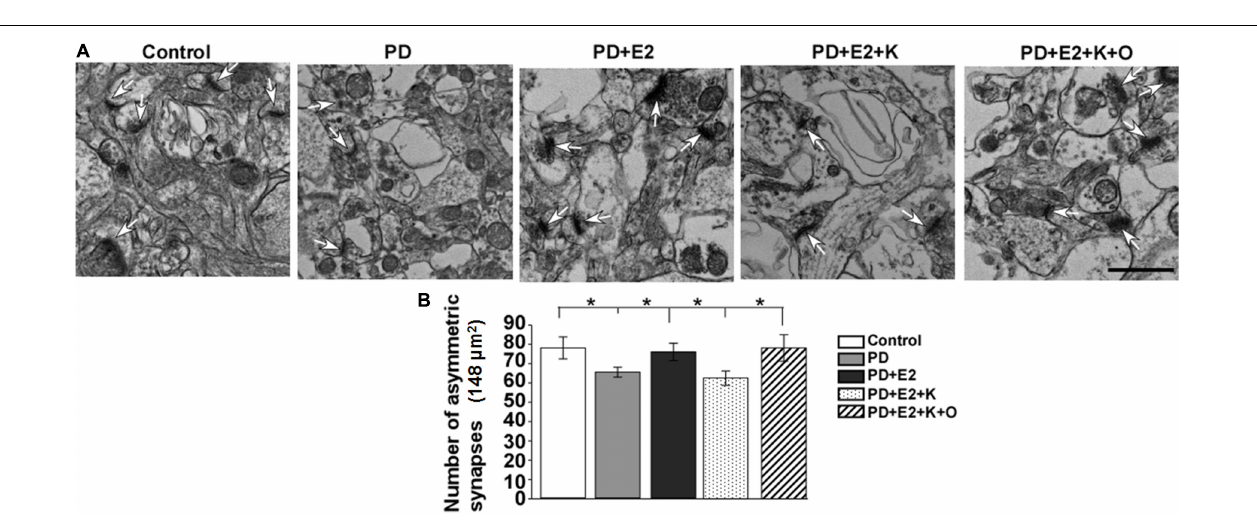
FIGURE 6 | (A) Electron micrographs and histograms (B) showing the changes in the number of asymmetric synapses in the hippocampus in all experimental groups. White arrowheads indicated the typical asymmetric synapses ( n = 3, each group). Results are presented as mean ± SEM. * p < 0.05. Scale bar = 1e p.